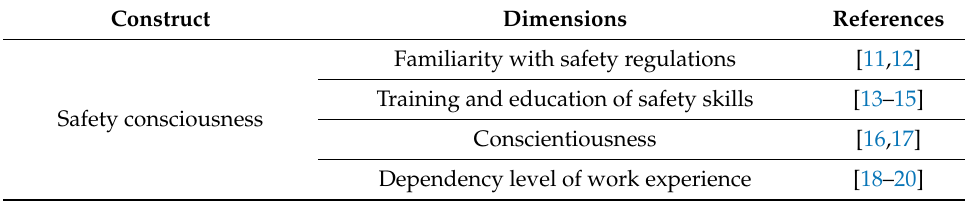
Table 1. Dimensions of safety consciousness and safety citizenship behaviour in the initial